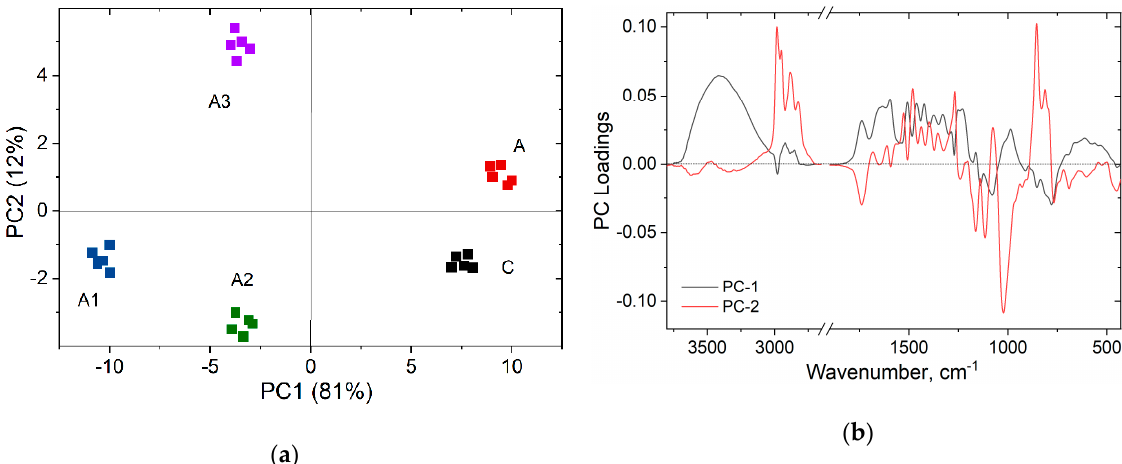
Figure 7. Principal component (PC) scores ( a ) and principal component (PC) loadings ( b ) calculated for the studied samples.